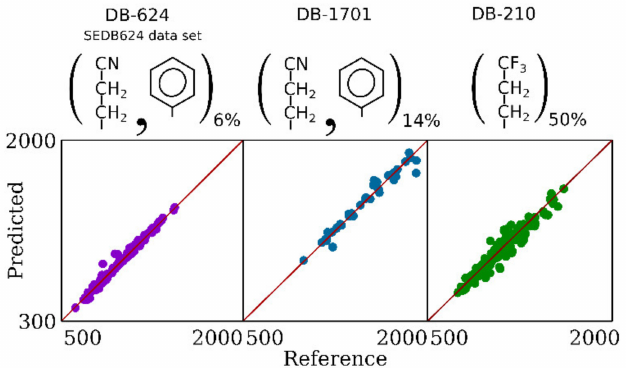
Figure 4. Comparison of predicted and reference values for SEDB624, DB-1701, and DB-210 data sets. RI prediction for other mid-polar SP, such as DB-210 (50% trifluoropropylmethyl 50% dimethyl polysiloxane) and DB-1701 (14% cyanopropylphenyl 86% dimethyl